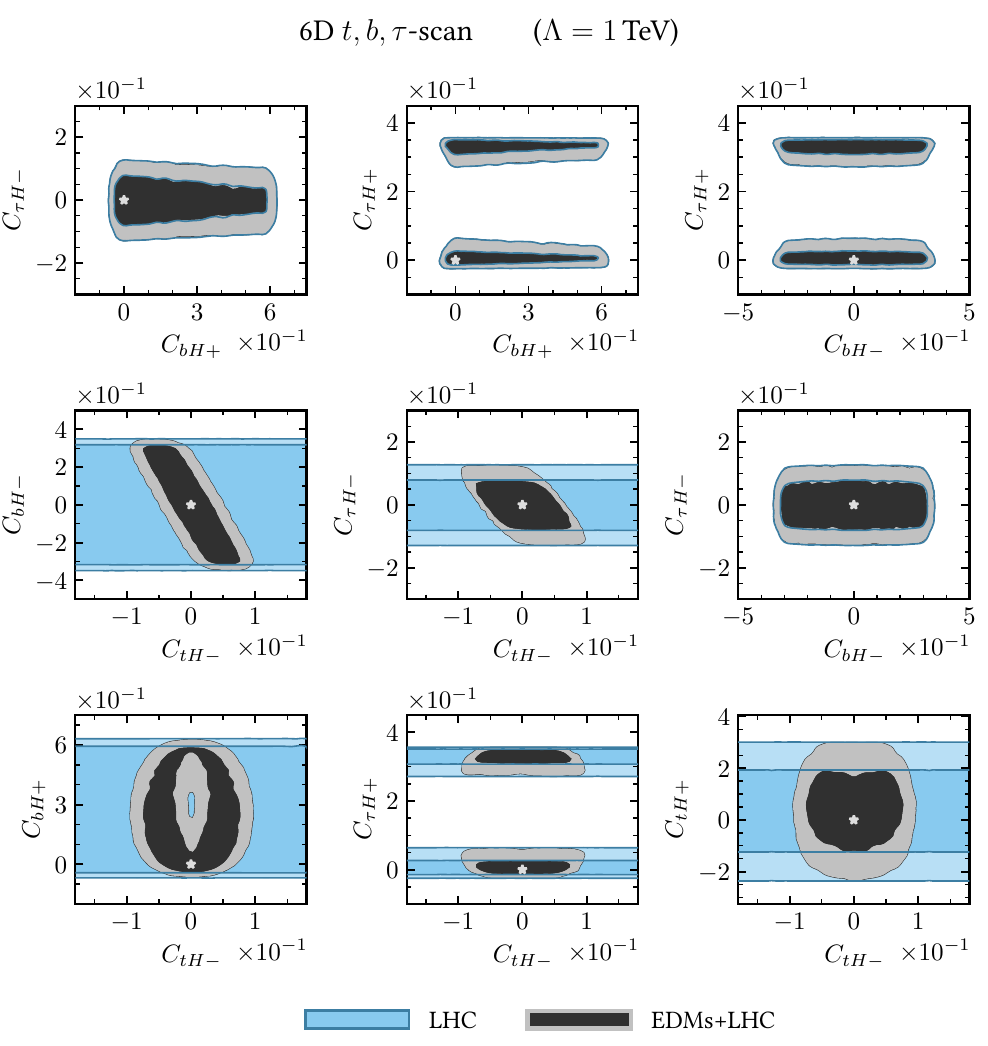
Figure 10 . Constraints resulting from a 6D scan of top, bottom, and τ Wilson coefficients ( C tH ± , C bH ± , C τH ± ) assuming Λ = 1 TeV. In each plot only two parameters are shown, the remaining ones are profiled over (see main text). Contours represent the allowed 68% and 95% confidence regions, the colour coding of individual constraints is given in the legend, and grey/black areas correspond to the combined regions. For details see main text and the caption of figure